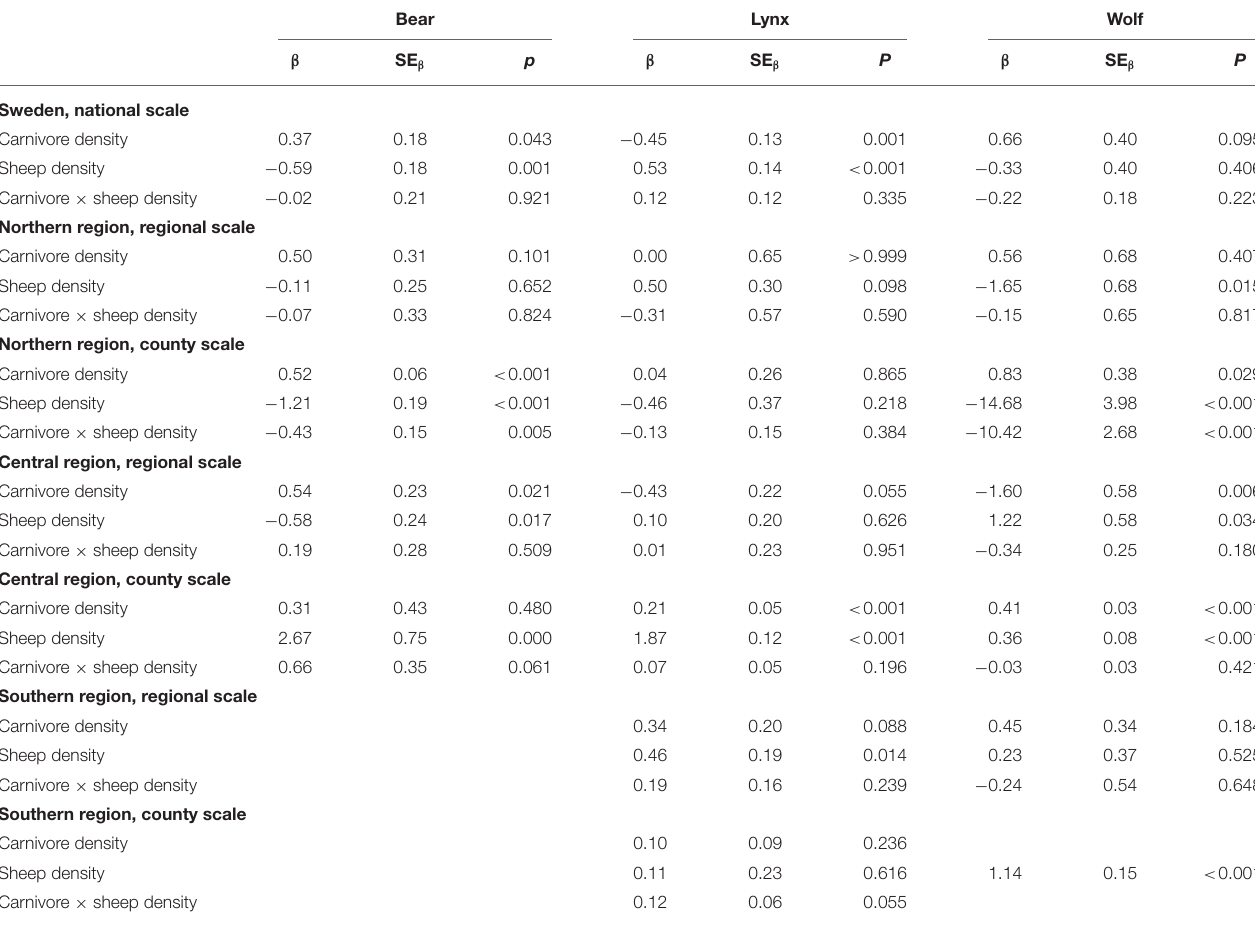
TABLE 2 | Beta coefficients describing the relationships between number of damaged sheep by brown bears, Eurasian lynx and gray wolves and densities of respective carnivore and sheep, as well interaction coefficients describing if the density of sheep influences the relationship between number of damaged sheep and densities of carnivores.